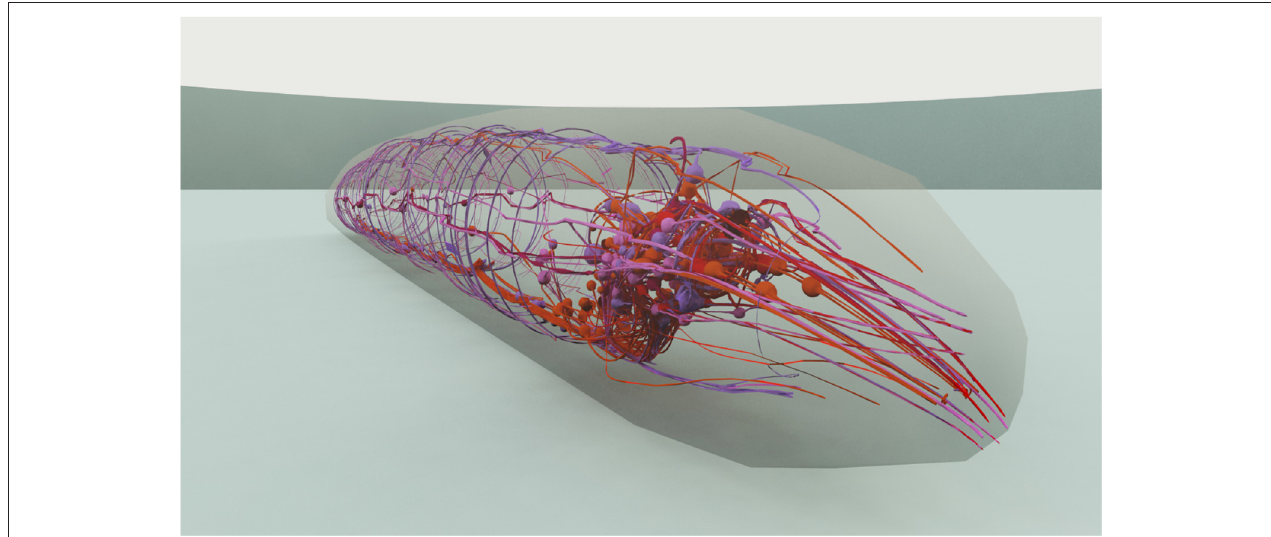
FIGURE 4 | 3D representation of the C. elegans that has been used for stimuli modeling. The cuticle is shown translucent in order to manifest the neurons and neural network within the worm. A close view on the worm’s head is